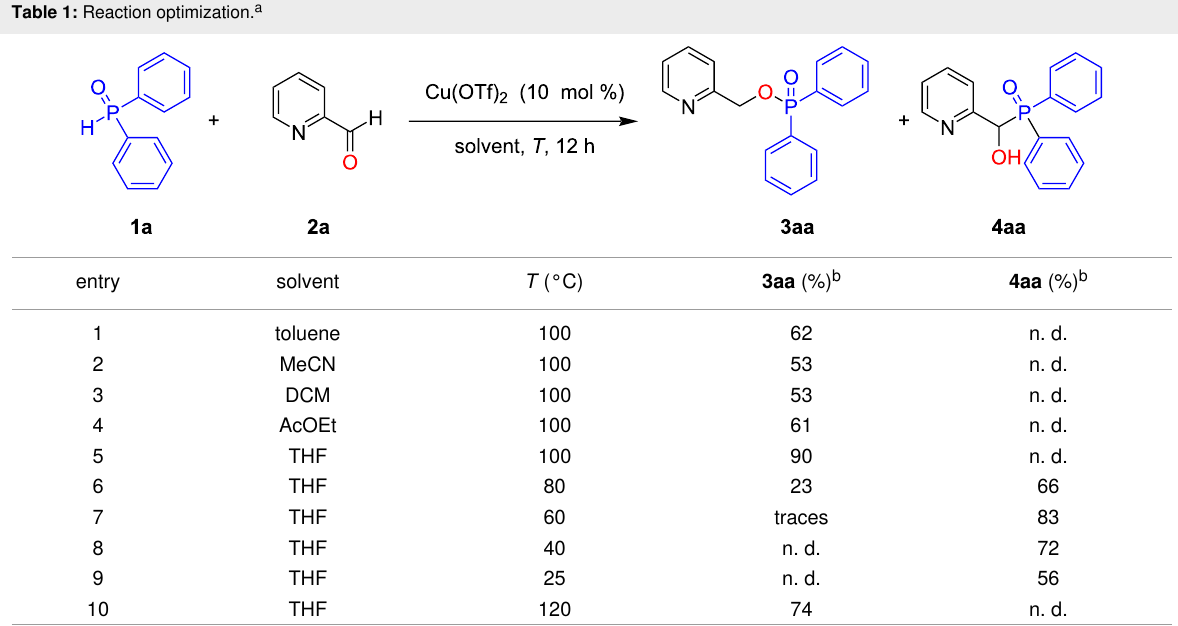
Table 1: Reaction optimization. a